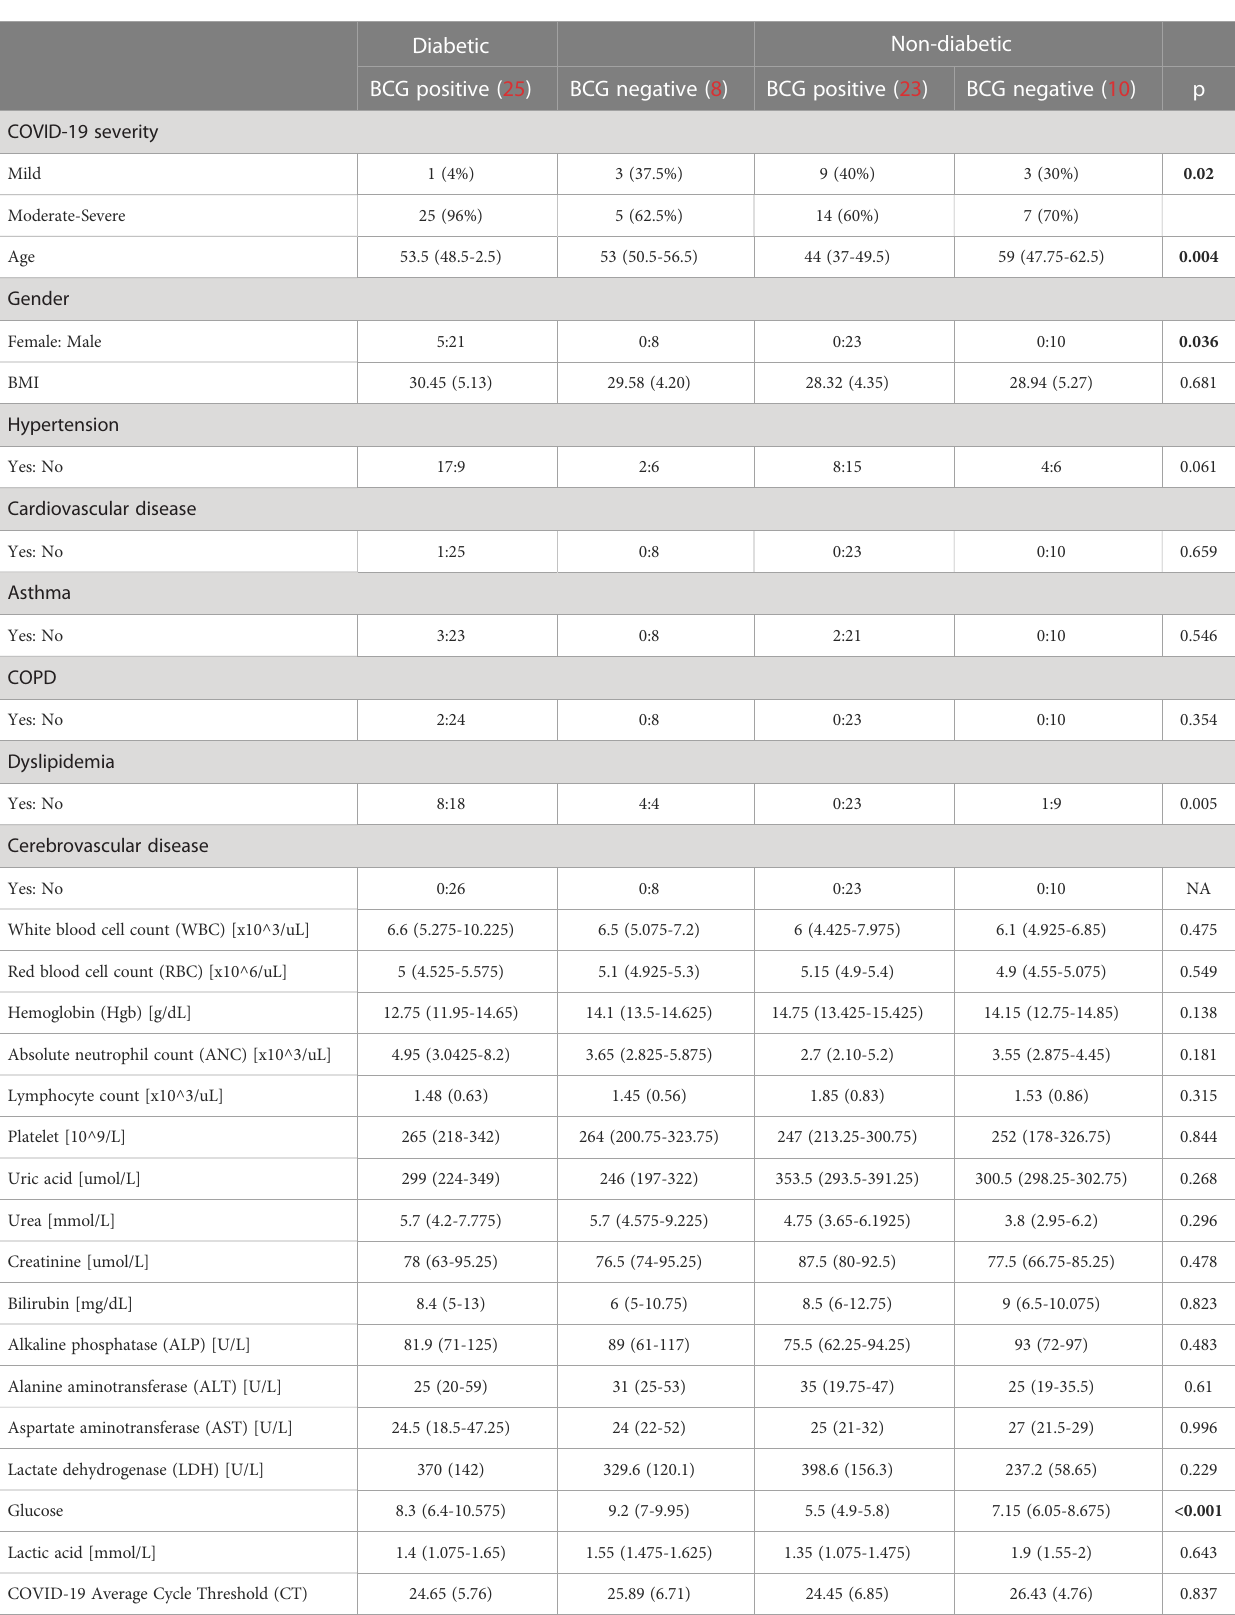
TABLE 1 Demographic characteristics of study participants categorized by diabetic status and BCG vaccination (positive and